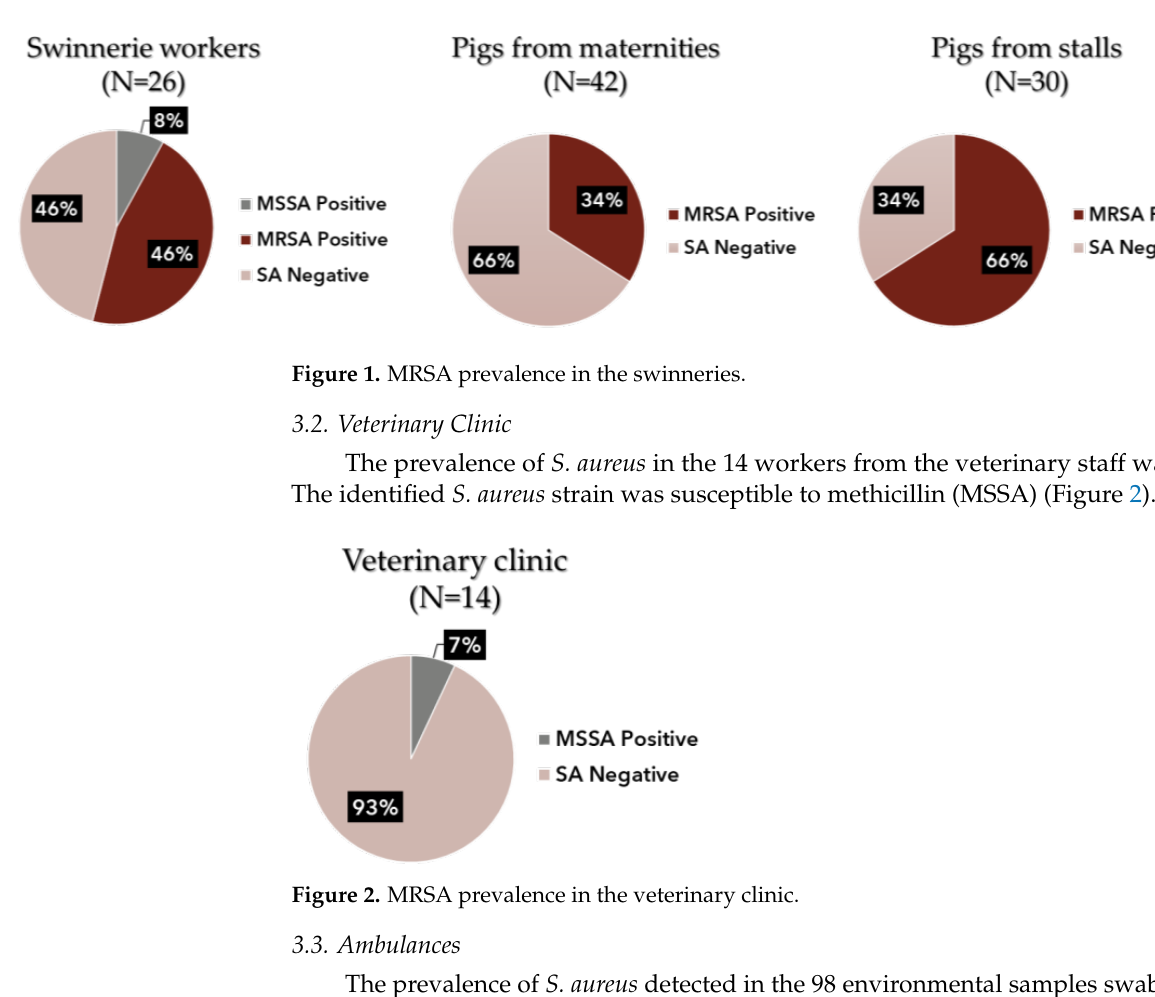
Figure 2. MRSA prevalence in the veterinary clinic .